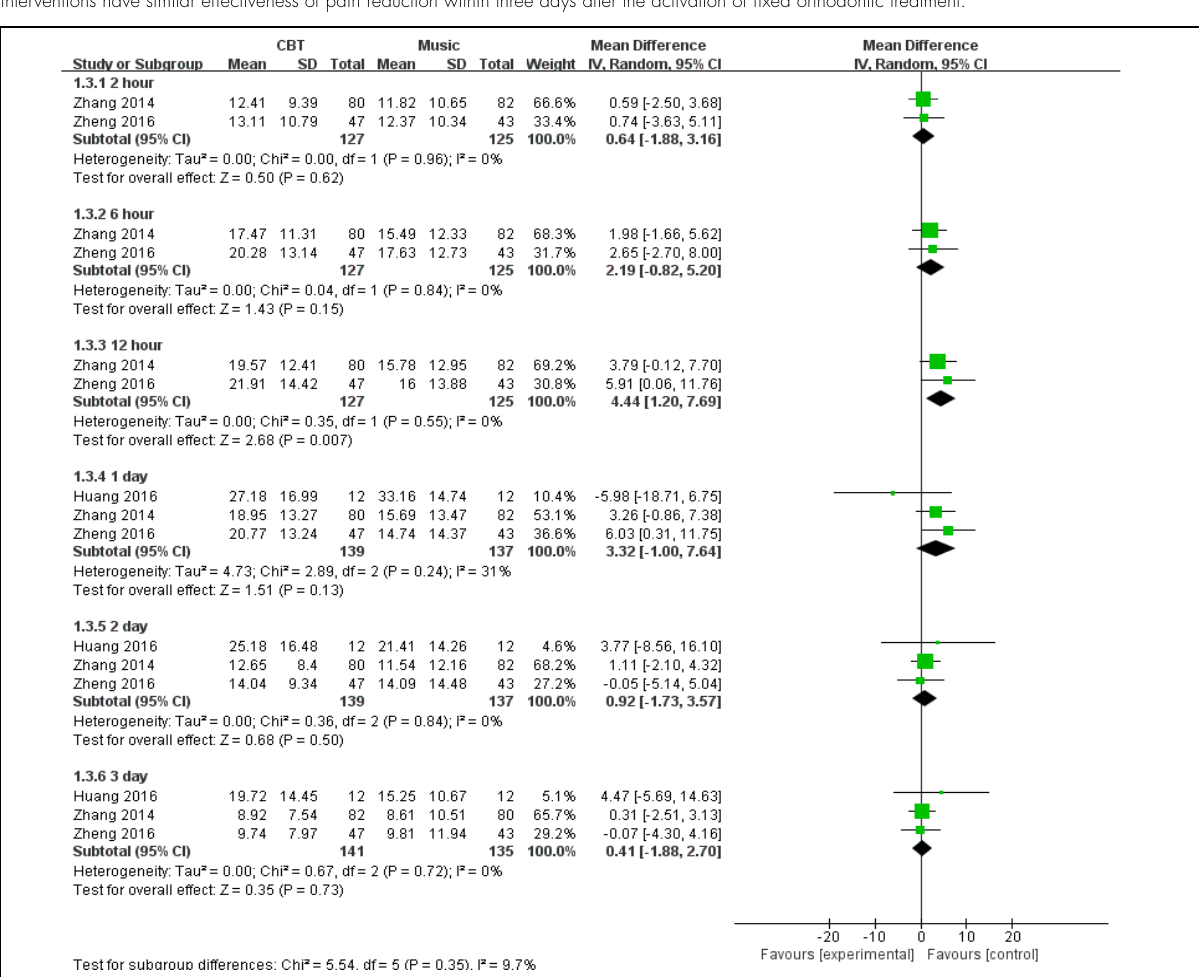
reduction within three days after the activation of fixed orthodontic